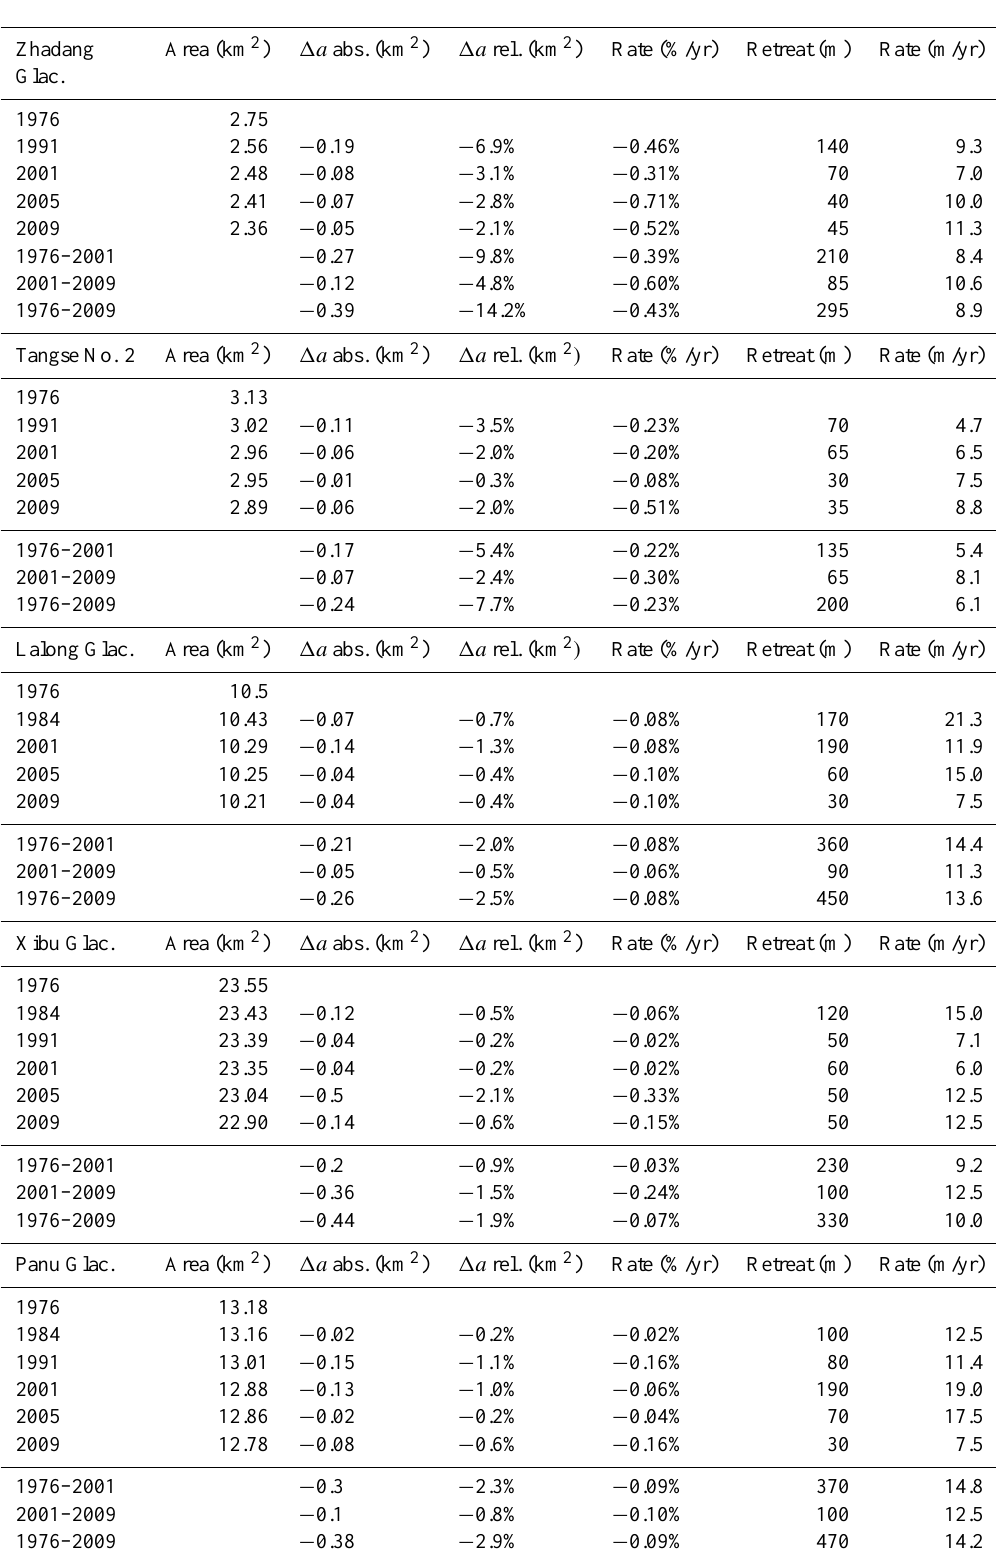
Table 5. Length and area changes for five selected glaciers. The uncertainty is estimated to be about 3%. Zhadang Area (km 2 ) 1a abs. (km 2 ) 1a rel. (km 2 ) Rate (%/yr) Retreat (m) Rate (m/yr) Glac. 1976 2.75